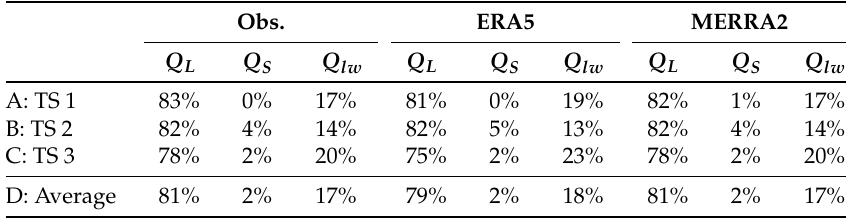
Figure 5. Daily average latent ( A , B ) and sensible ( C , D ) heat fluxes derived from reanalysis products (ECMWF-ERA5 blue and NASA-MERRA2 red) and observations (black). Differences can be seen at the Sea Island and Qarooh Island stations. Positive differences indicate overestimates, and vertical dashed lines indicate spring wind events (green), summer Shamals (blue), tropical storms (magenta), and winter Shamals (orange). ∆ Q L ( A ) and ∆ Q S ( B ) represent the difference between reanalysis products and observations. Table 1. Relative contributions of latent heat flux, sensible heat flux and longwave radiation to net cooling, based on observations (Obs.) and the ECMWF-ERA5 and NASA-MERRA2 reanalysis products. (A–C) Values during the three tropical storms TS 1 (A), TS 2 (B), and TS 3 (C). (D) Averaged cooling contributions based on all three tropical storm